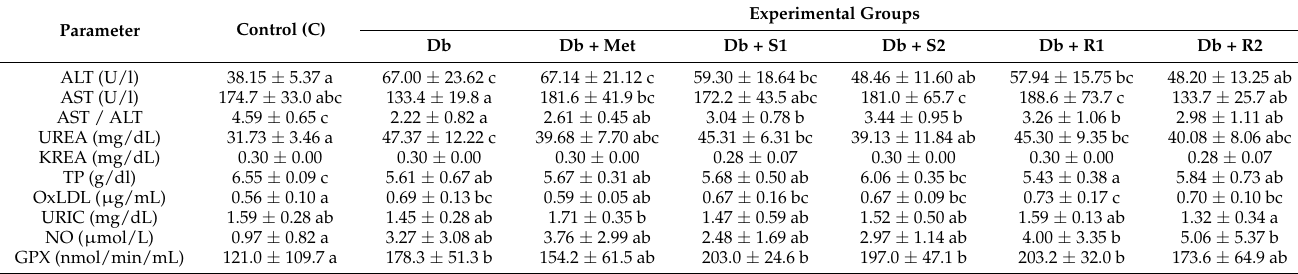
Figure 4. Effect of diet and supplementary SGs on appetite regulatory biomarkers. (A) Ghrelin: total ghrelin, (B) Leptin, (C) Adiponectin, (D) Adiponectin/Leptin: adiponectin to leptin ratio in serum of experimental rats. Data are presented as mean ± standard deviation (M ± SD). Values with different letters (a–c) show statistically significant differences ( p < 0.05, a < b, Fisher’s LSD test). Table 2. Effect of diet and supplementary SGs on selected blood biochemical indices in